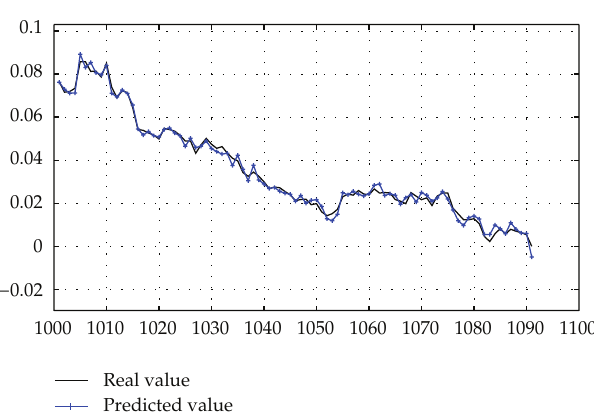
Figure 2: Predicted result of Shenzhen component index (cid:4) 1000 fitting data (cid:5) .